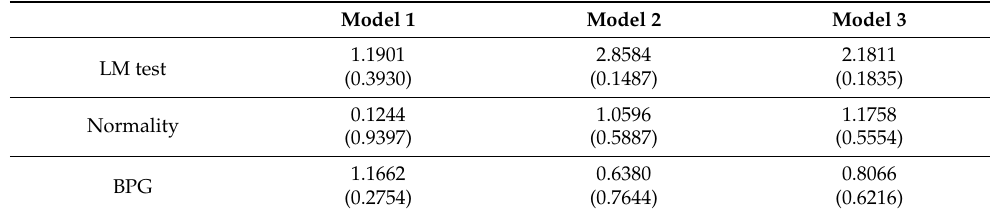
Table 6. Diagnostic test